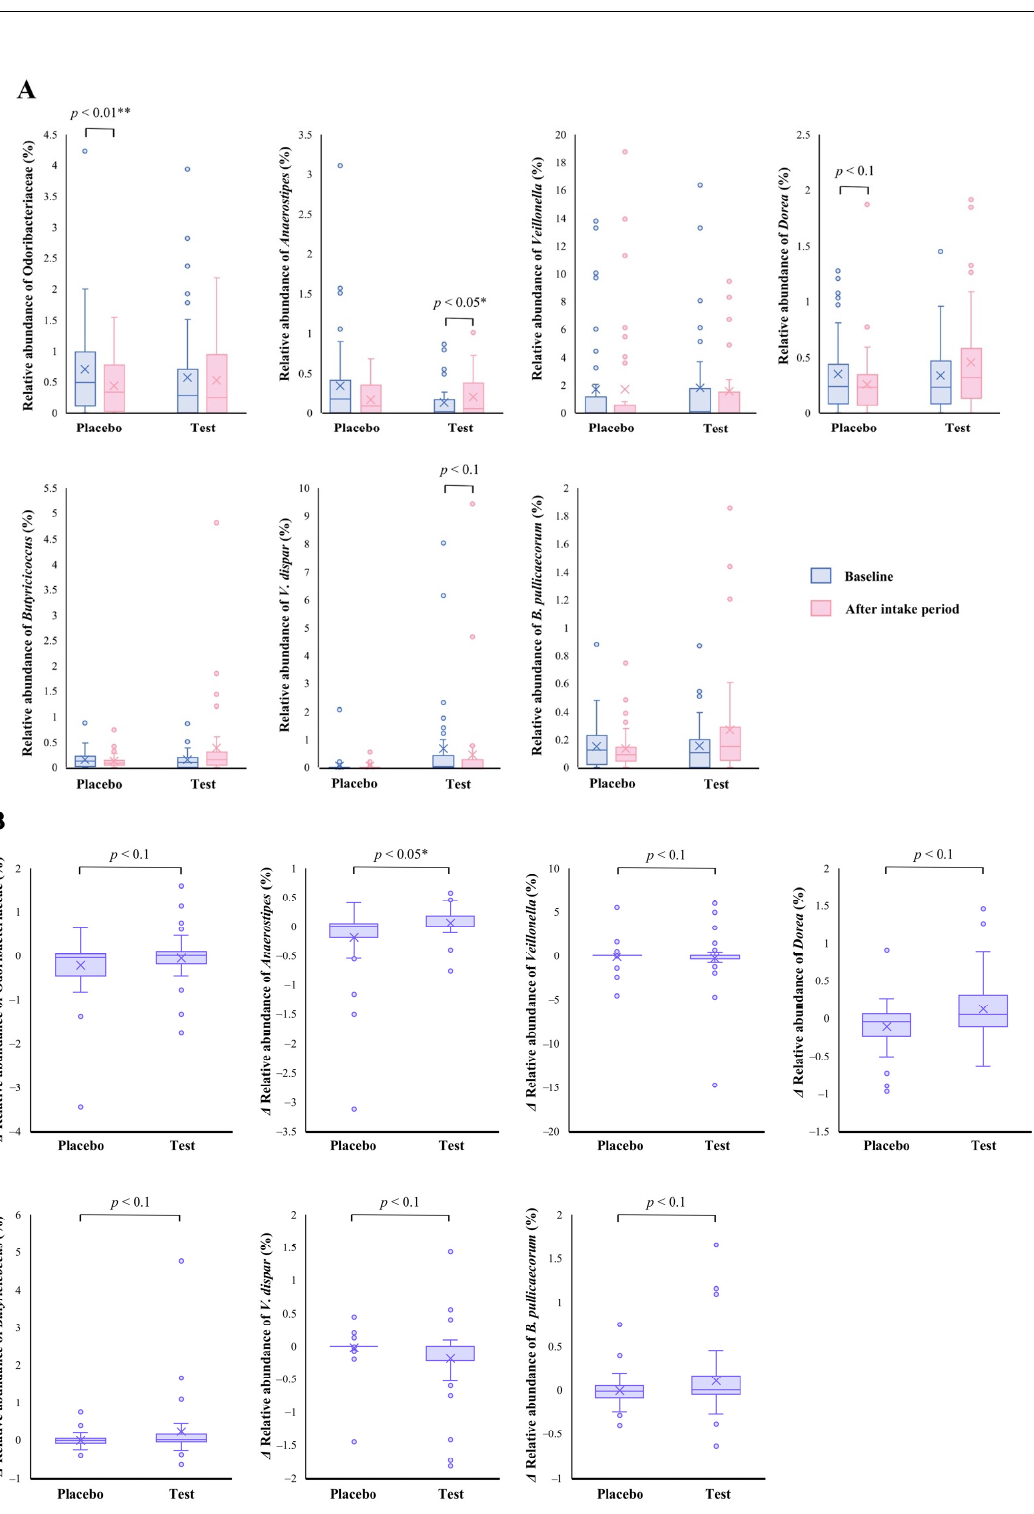
Figure 2. Comparison of relative abundance before and after the intake period ( A ) and the changes in relative abundance from the baseline of fecal microbiota ( B ) between the test ( n = 39) and placebo ( n = 41) groups on Odoribacteraceae, Anaerostipes , Veillonella , Dorea , Butyricicoccus , Veillonella dispar , and Butyricicoccus pullicaecorum . The statistical analyses were performed using the Mann–Whitney U test and Wilcoxon’s signed rank test for inter- and intra-group analyses, respectively (* p < 0.05 and ** p < 0.01). Data are shown as a box plot with medians (line inside boxes), means (cross mark), 25–75th percentile (limits of boxes), whiskers indicating a 95% data range, and outliers indicated by circles.